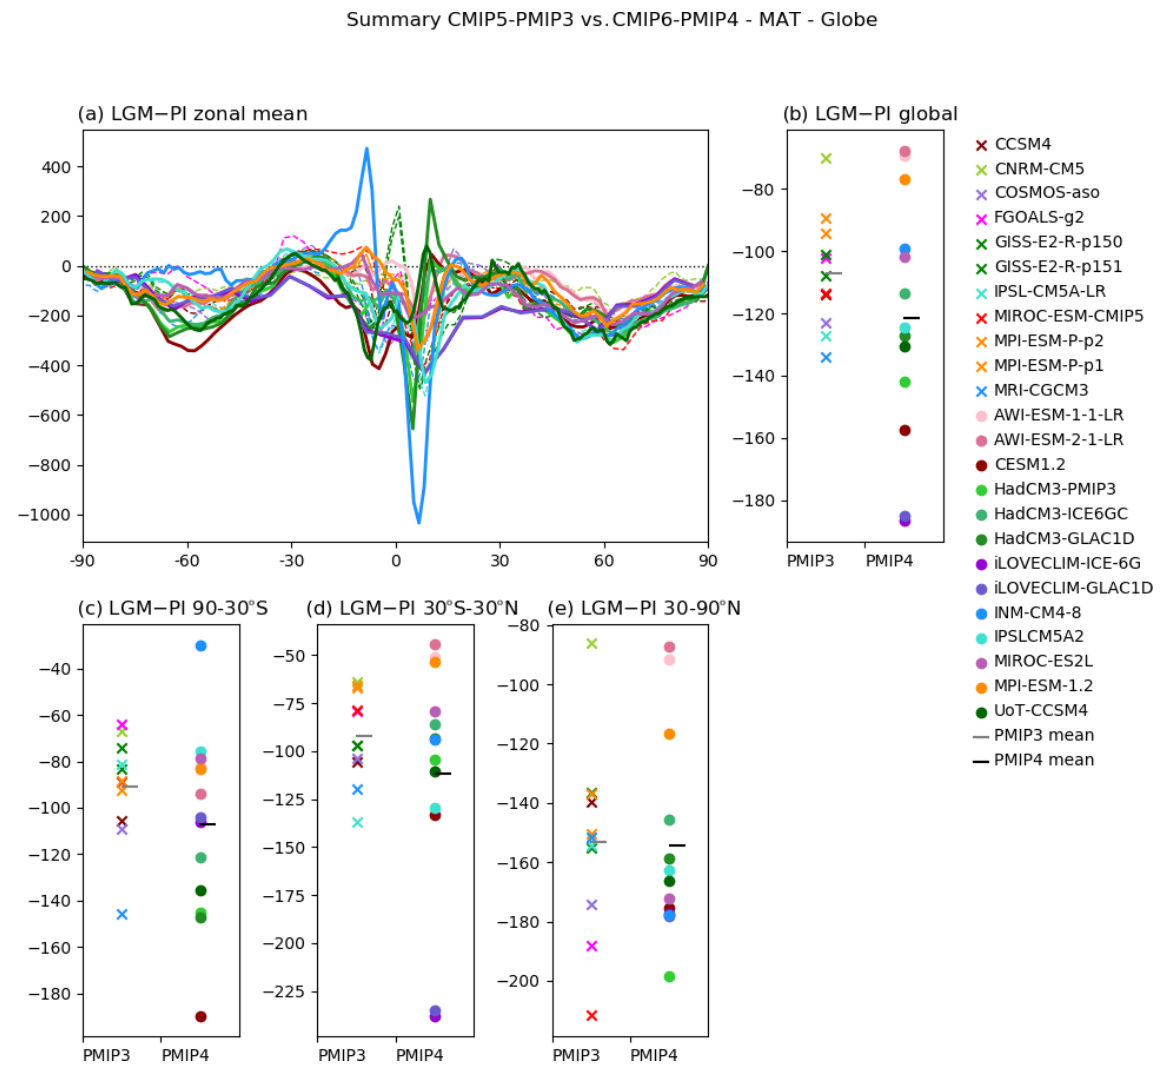
Figure 7. Same as Fig. 1 for mean annual precipitation in mmyr − 1